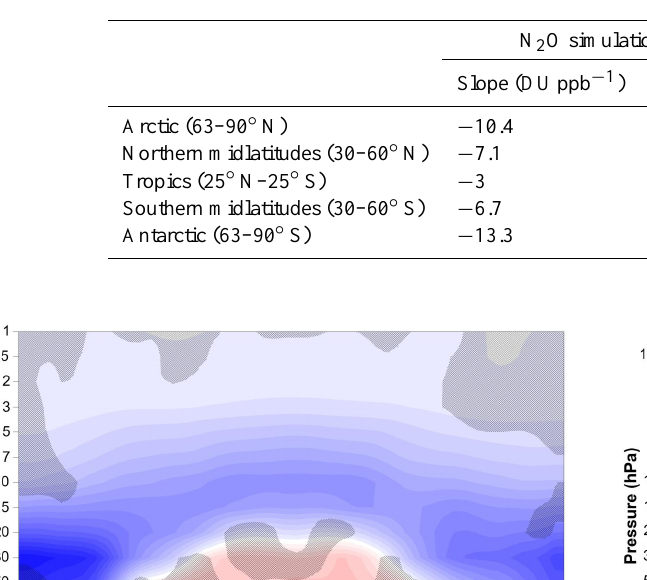
Table 2. Linear regression model slopes and R 2 -values.